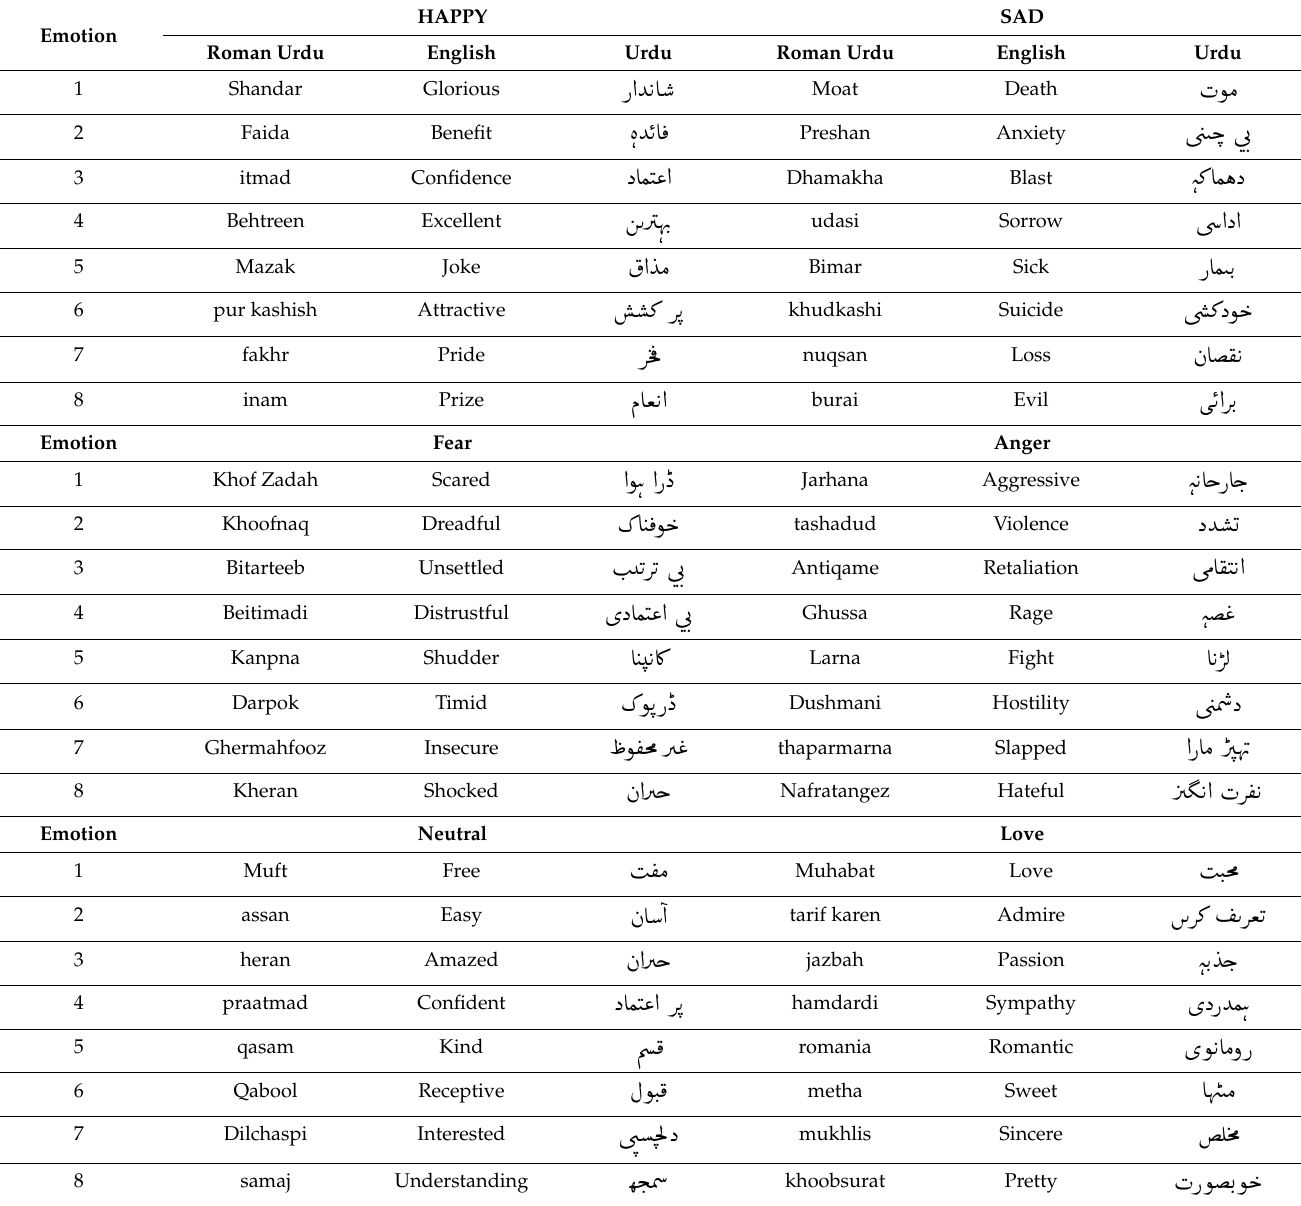
Table 5. Keywords Sample for Emotion